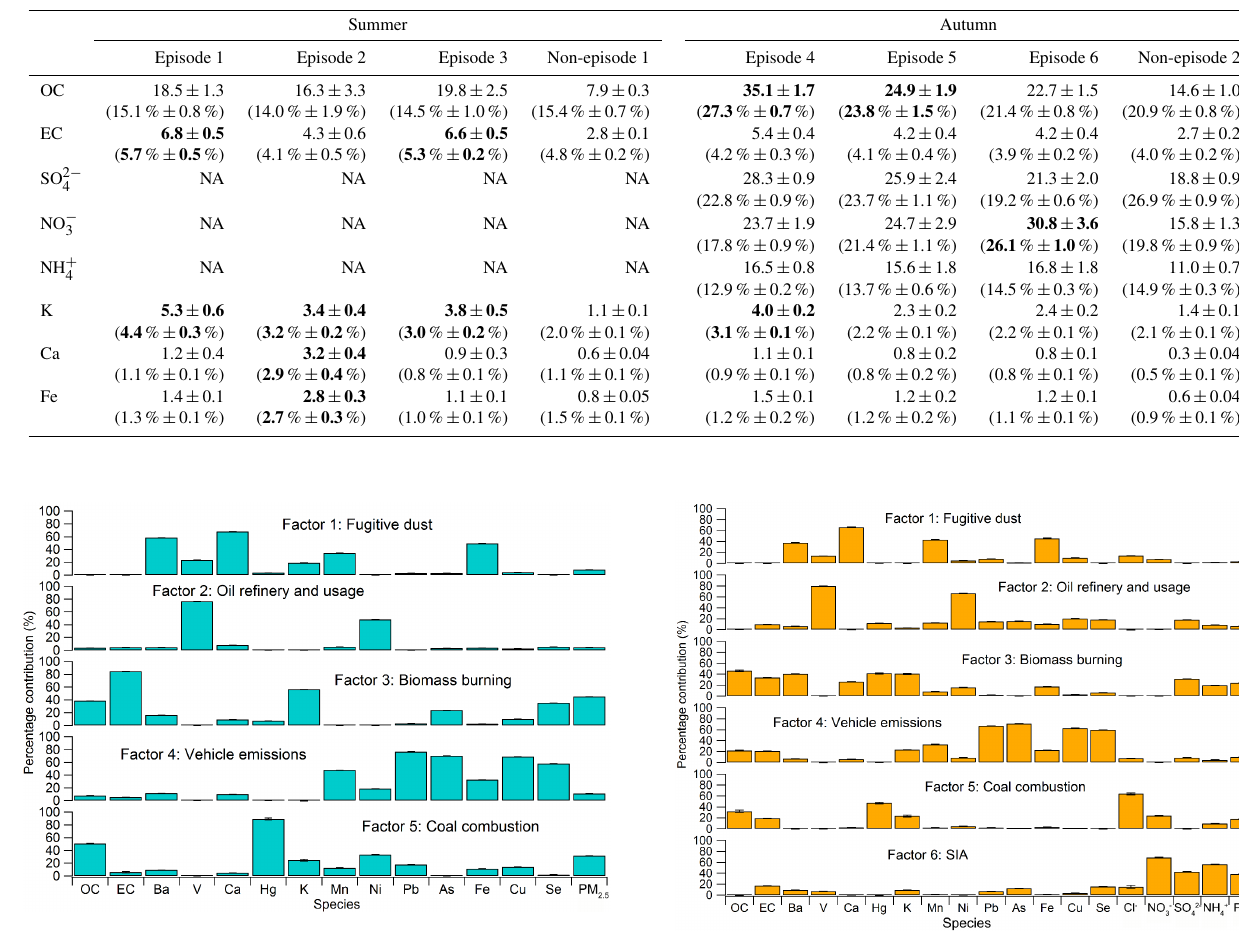
Table 3. Concentrations (µgm − 3 ) and percentages (in parentheses) of the main components of PM 2 . 5 during non-episodes and episodes. Bold font demonstrates significant increase in percentage of PM 2 . 5 components during episodes compared to non-episodes.